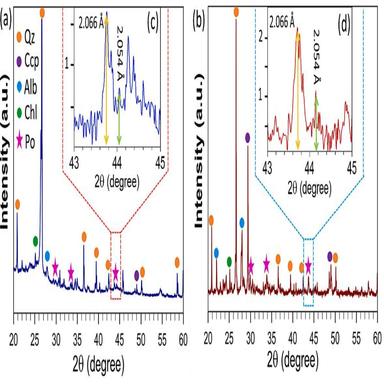
X-ray diffraction pattern of (a) the ore sample and (b) the flotation concentrate sample. Insets (c) and (d) display the magnified XRD data covering the range of 2θ = 43◦ to 45◦, highlighting the distinctive pyrrhotite peaks.